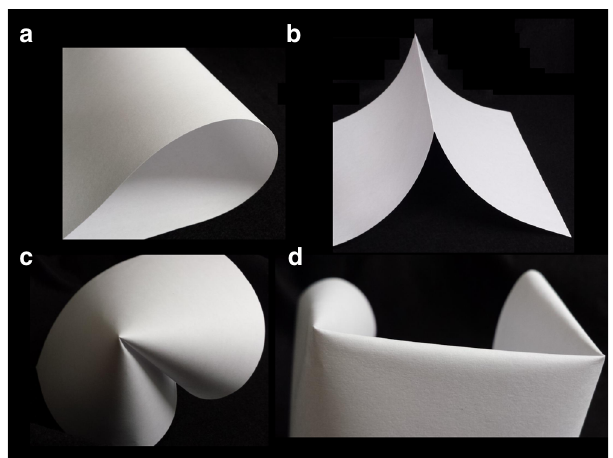
Fig. 1 Four fundamental building blocks of origami and crumpled matter. a A bend. b A fold. c A developable cone. d A stretching ridge formed between two developable